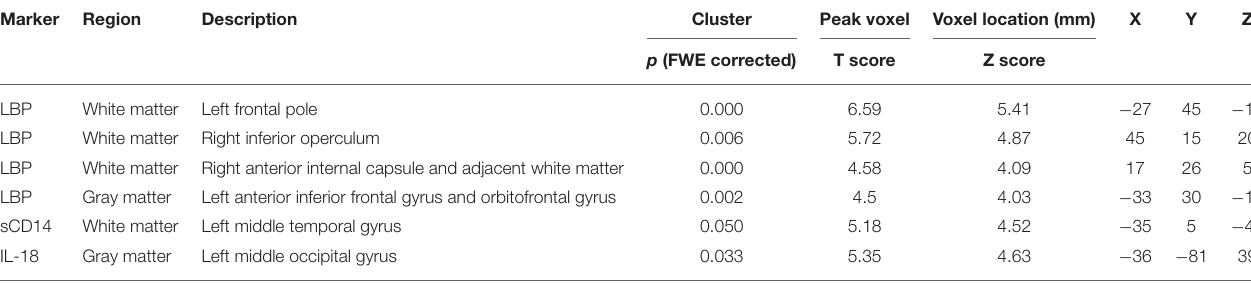
TABLE 2 | Brain atrophy is associated with elevated plasma markers in GRN carriers. Marker Region